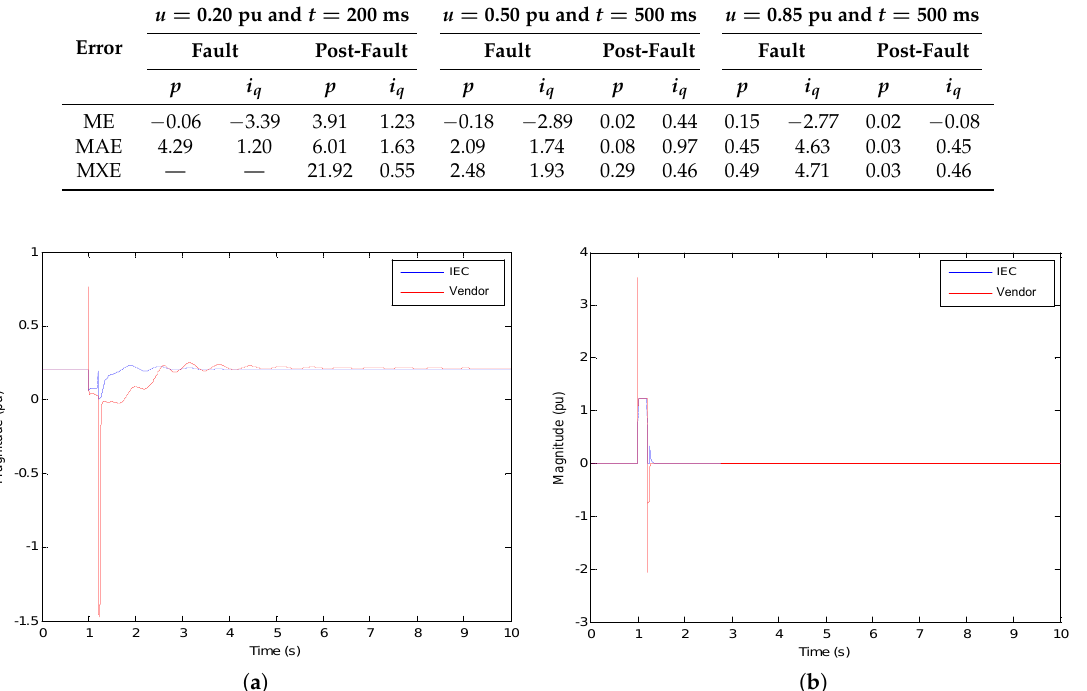
Figure 4. Type IIIB results. Simulation scenario: p = 0.20 pu, u = 0.20 pu, t = 200 ms. ( a ) Active power, p ; and ( b ) reactive current, i q